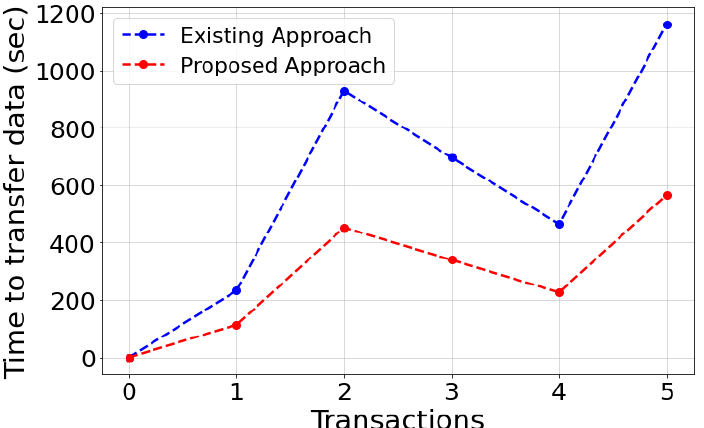
Figure 7. Transfer rate comparison.